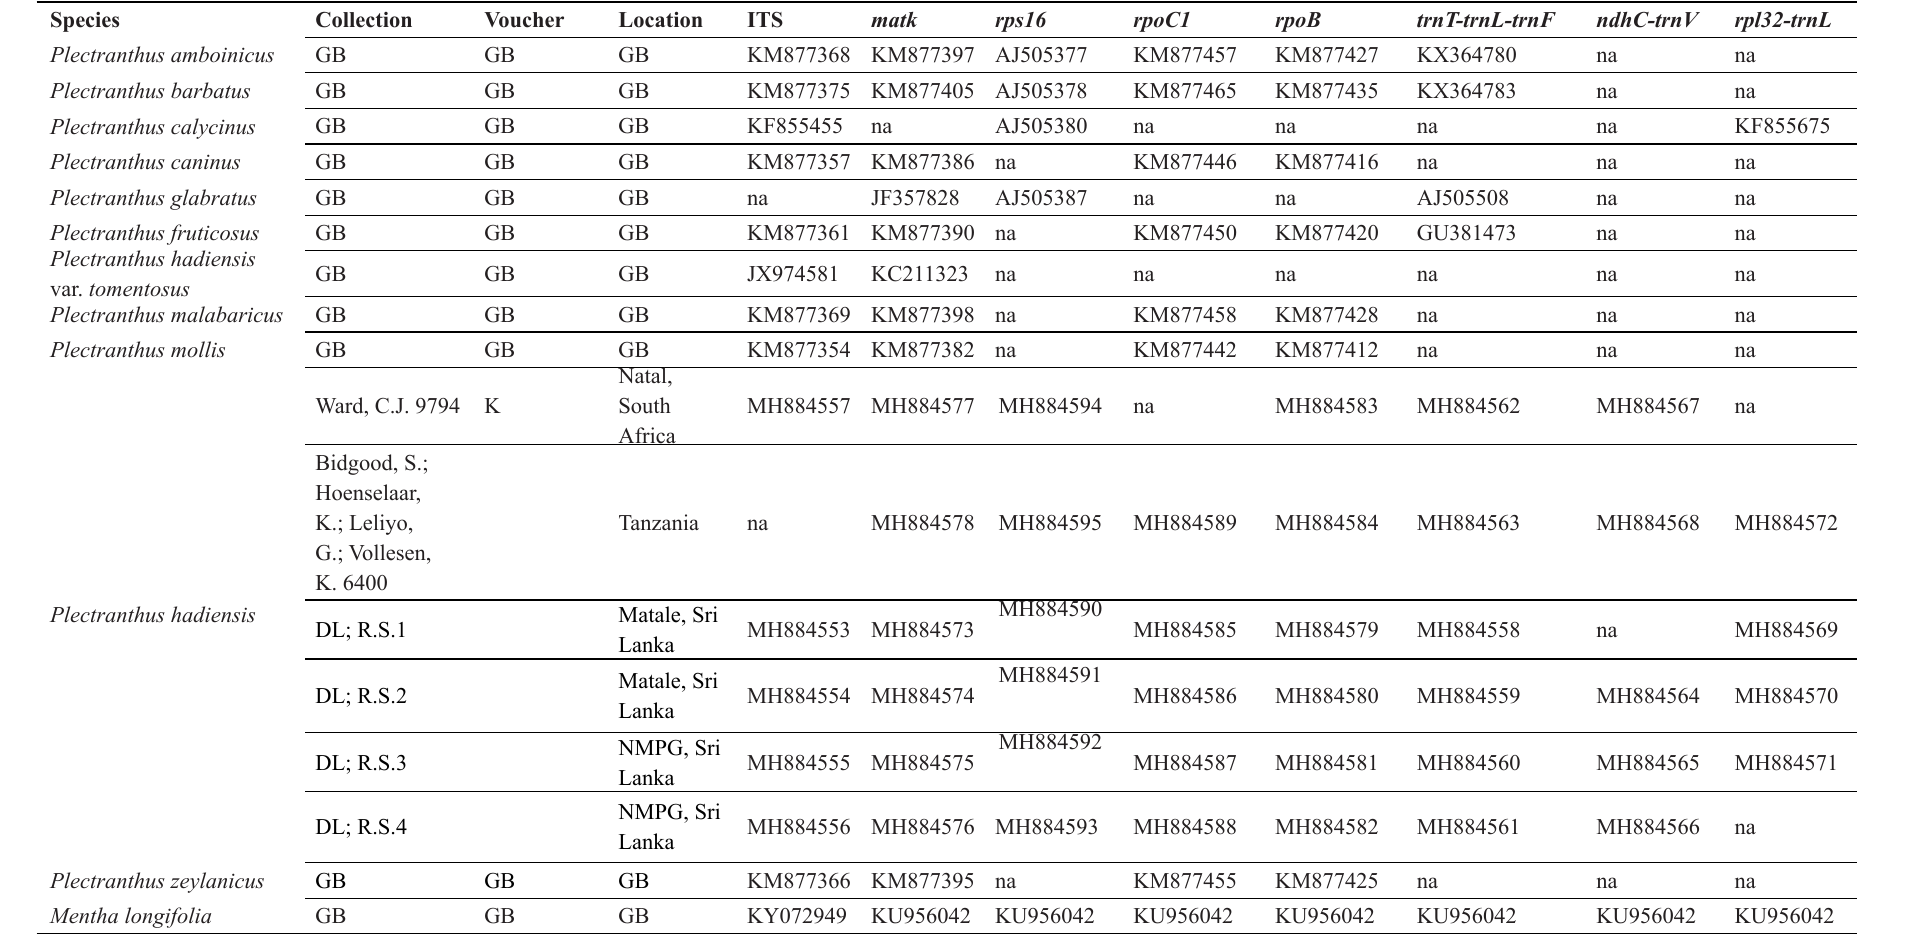
Table 1: Specimens and accessions used in this study. The collection number, herbarium voucher, and location are given for newly generated sequences in this study. GenBank accession numbers of species used for phylogenetic analysis are stated. Abbreviations: DL, D. Large (field collector); na, not available; NMPG, National Medicinal Plants Garden, Ganewatte, Sri Lanka. Herbarium codes: K, Royal Botanic Gardens Kew, U.K; GB, sequence obtained from